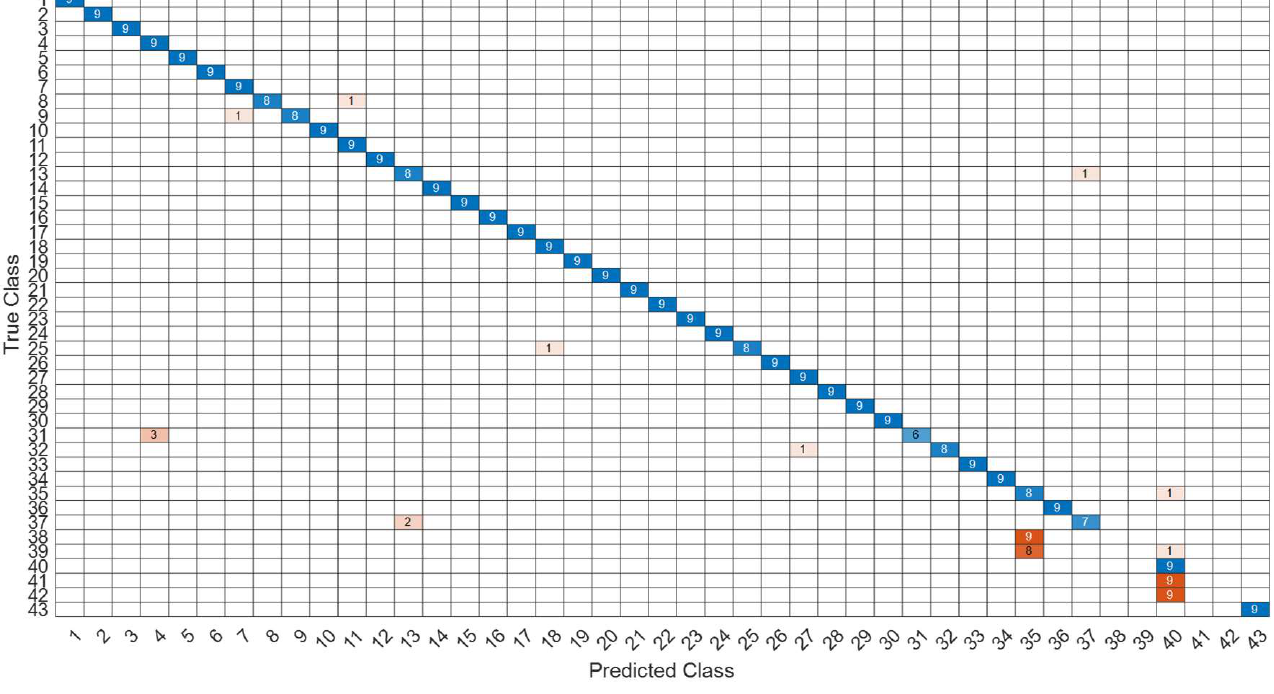
Figure 25. The confusion matrix of the LSTM model with wavelet 30-features dataset.